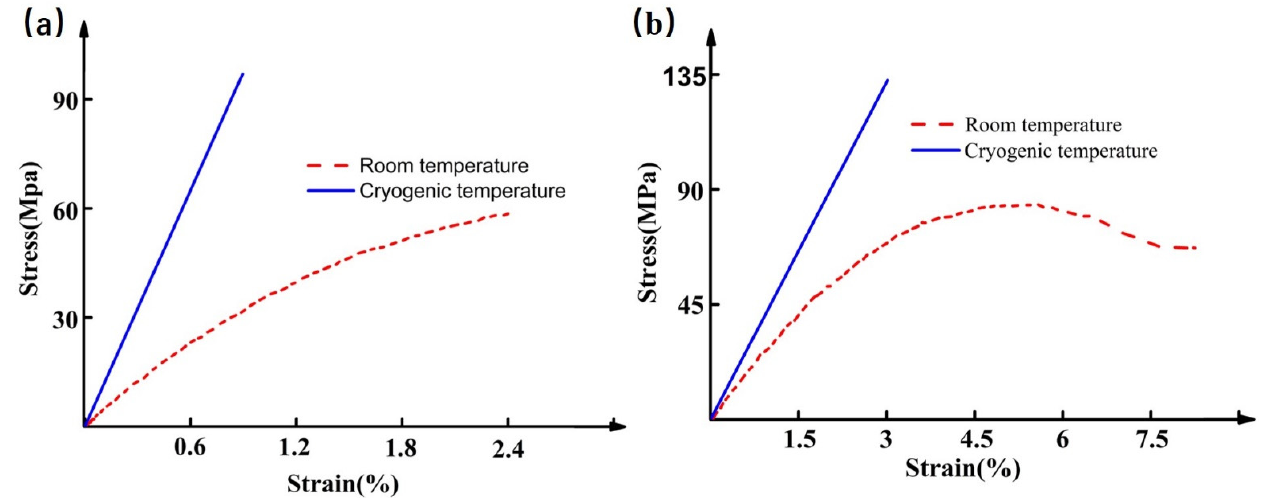
Figure 1. The typical tensile stress-strain behaviors of ( a ) thermoset polymer and ( b ) thermoplastic polymer under room and cryogenic temperature.